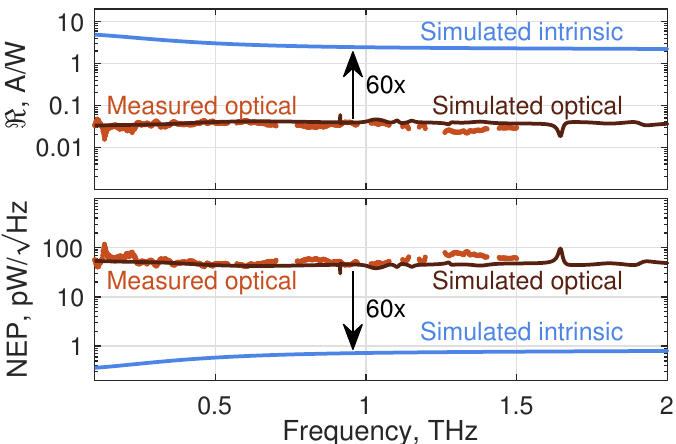
Figure 2. Simulated intrinsic (blue) and optical (black) responsivity and noise-equivalent power (NEP) of the TeraFET with an integrated log-spiral antenna. The brown dots represent the measured data. Black arrows indicate the ratio between the intrinsic and the optical quantities. The calculations cover the range 0.1–2 THz as the simulations for higher frequencies would have required much more computational resources. The experiments were limited upwards to 1.5 THz by the sensitivity range of the pyroelectric and Golay cell power meters used for power